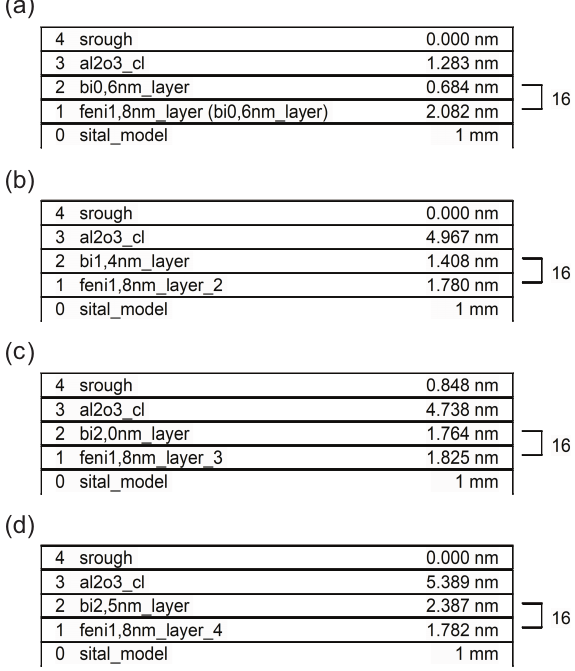
Figure 3. The multilayer model applied for the simulation of the Al 2 O 3 /[Bi(0.6, 1.4, 2.0, and 2.5nm)– FeNi(1.8nm)] 16 /Sitall samples. The Bi and FeNi thicknesses estimated from the model simula- tions are ( a ) 0.684 ± 0.037nm and 2.082 ± 0.116nm, ( b ) 1.408 ± 0.574nm and 1.780 ± 0.65nm, ( c ) 1.764 ± 0.194nm and 1.825 ± 0.358nm, and ( d ) 2.387 ± 0.128nm and 1.782 ± 0.171nm. Note the good agreement between the thicknesses of the FeNi and Bi layers estimated from the model simulations and their respective nominal thickness values. The roughness and Al 2 O 3 capping layer thicknesses estimated from the model simulations are ( a ) 0.00 ± 3.85nm and 1.283 ± 2.37nm, ( b ) 0.000 ± 4.97nm and 4.967 ± 2.17nm, ( c ) 0.848 ± 5.86nm and 4.738 ± 2.92nm, and ( d ) 0.000 ± 2.95nm and 5.389 ±